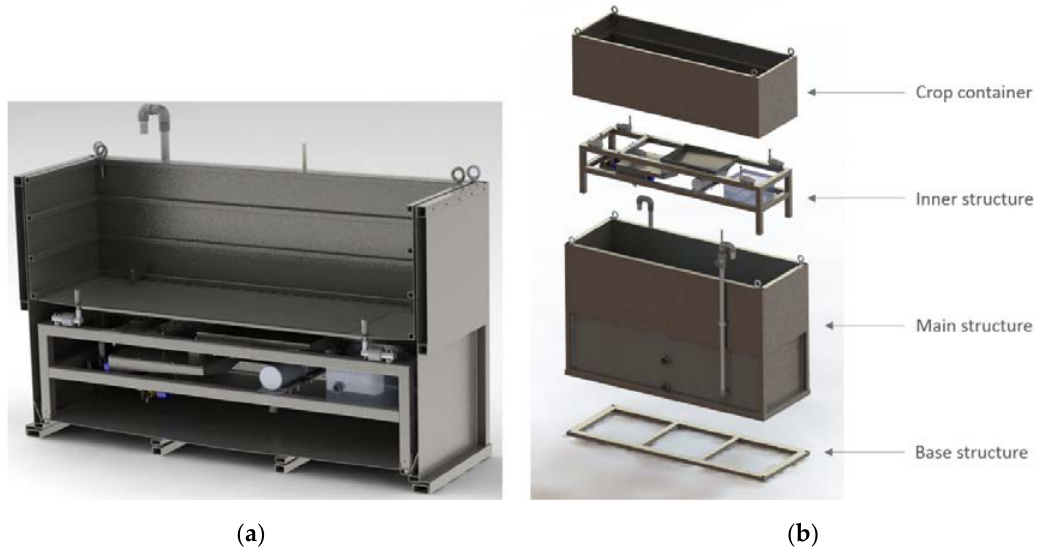
Figure 9. Three-dimensional model of the ferticontrol equipment based on weighing lysimeter: ( a ) cross-sectional view of the equipment; ( b ) exploded view of the equipment with its main structures.